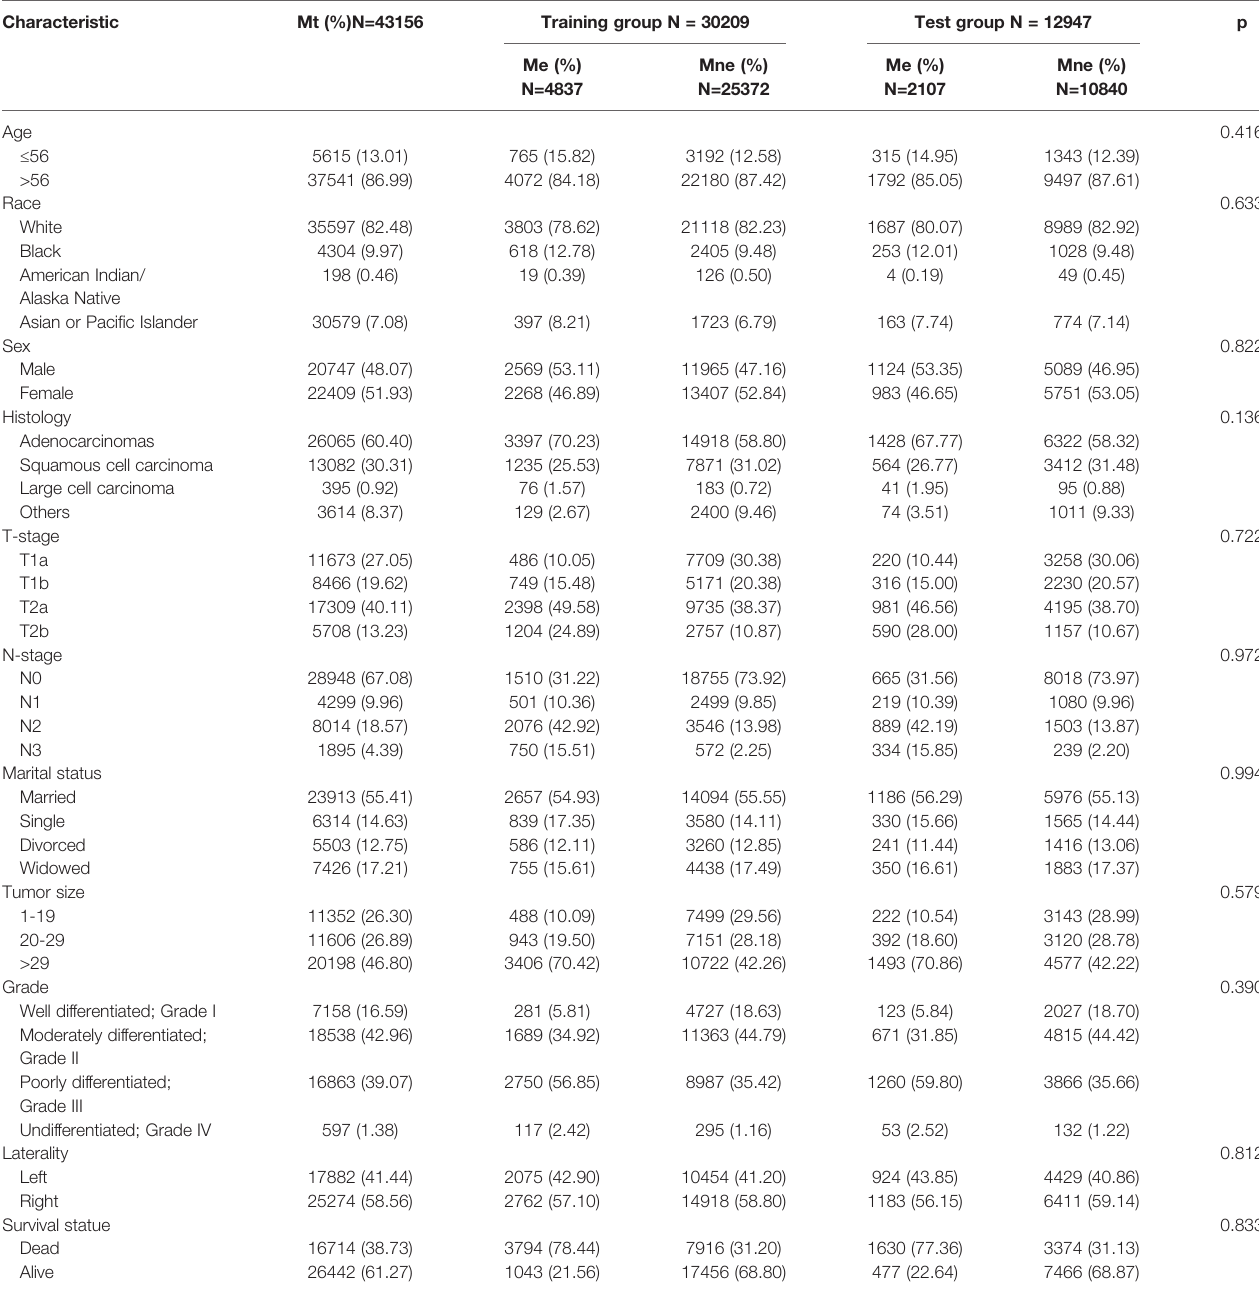
P-value indicates the baseline comparison between training group and test